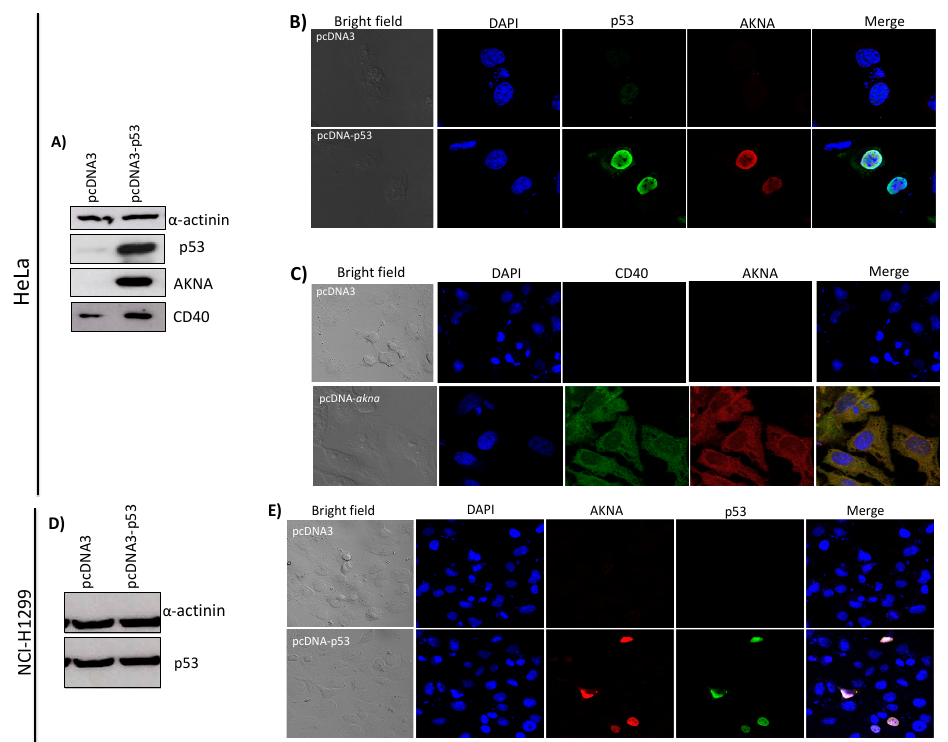
Figure 6. AKNA is expressed after p53 restoration in HeLa and NCI-H1299 cells. ( A ) HeLa cells were transfected with a p53 expressing plasmid (pcDNA3-p53). After 24 h of transfection, cells were harvested, and total protein extracted using sample buffer. AKNA, CD40 and p53 protein levels were ascertained by western blot using AKNA anti-serum, anti-CD40 and anti-p53 antibodies. As expected p53 protein levels increased in cells transfected with the pcDNA3-p53 plasmid and AKNA levels become visible as well as CD40 protein levels in the same cells compared with the cells transfected with the control vector (pcDNA3). α -actinin was used as a loading control. ( B ) HeLa cells were transfected, fixed and stained for immunofluorescence analysis using AKNA anti-serum, anti-p53 and anti-CD40 followed by Alexa 488 and 555 secondary antibodies. p53 expressing cells showed a massive recovery in AKNA signal in the nucleus indicating the p53 dependent effect of AKNA. ( C ) HeLa cells were transfected with either pcDNA3 or the pcDNA3- akna plasmid, then cells were fixed and stained for immunofluorescence analysis using AKNA anti-serum and anti-CD40 antibodies followed by Alexa 488 and 555 secondary antibodies. Cells expressing AKNA exhibit a strong CD40 signal. ( D ) NCI-H1299 cells were transfected with pcDNA3-p53 plasmid. Twenty-four h after transfection, cells were collected and p53 expression assessed by western blot. ( E ) NCI-H1299 transfected cells were fixed and stained for immunofluorescence analysis using AKNA anti-serum and anti-p53 antibodies (Santa Cruz Biotechnology) followed by Alexa 488 and 555 secondary antibodies. p53 expressing cells show an evident AKNA signal. Slides were mounted using Prolong